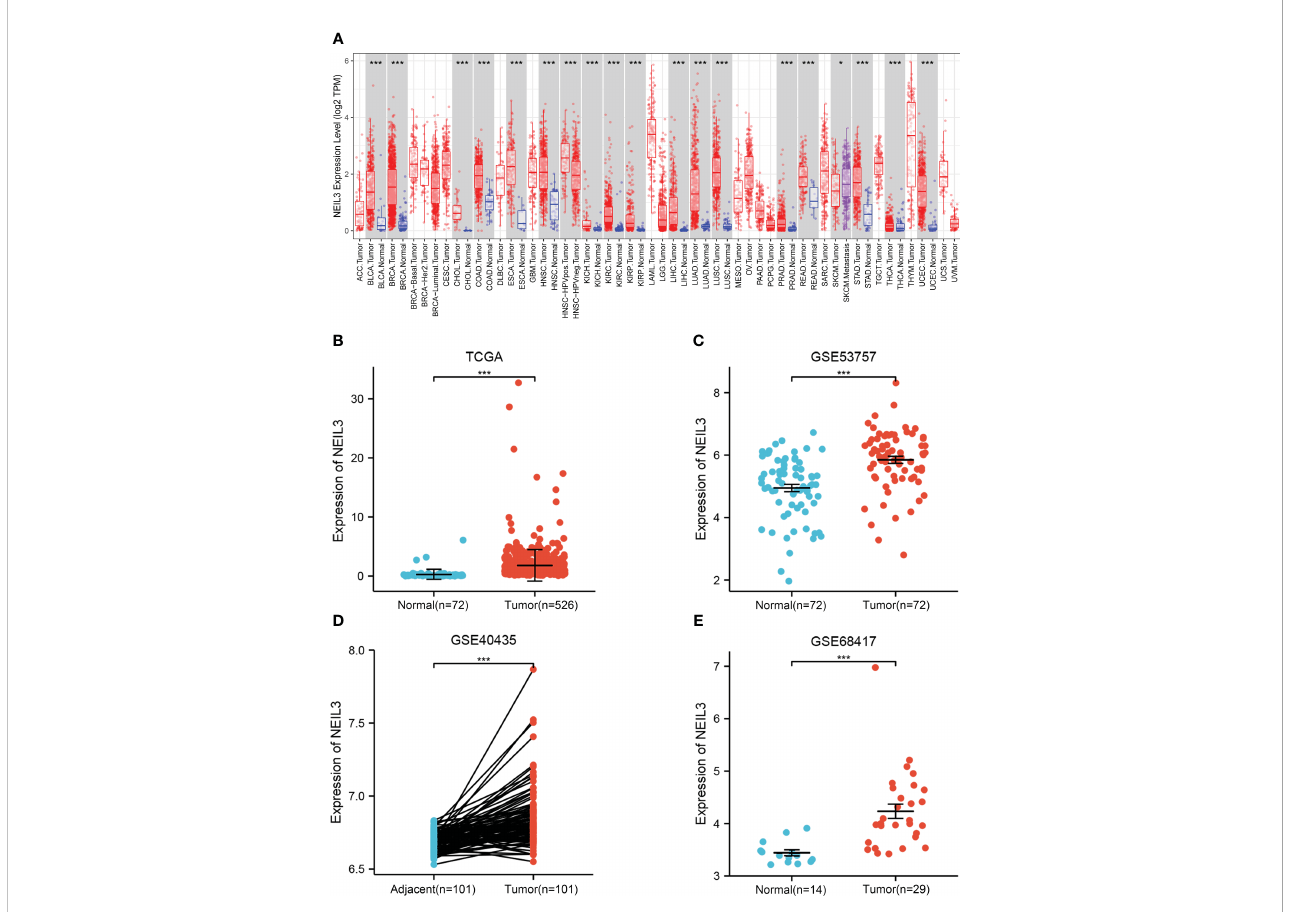
FIGURE 1 The expression level of NEIL3 is upregulated in KIRC. (A) Differential expression of NEIL3 between different tumors and adjacent normal tissues. NEIL3 is overexpressed in kidney renal clear cell carcinomas (KIRC), urothelial bladder carcinoma (BLCA), breast cancer (BRCA), colon adenocarcinoma (COAD), esophageal carcinoma (ESCA), liver hepatocellular carcinoma (LIHC), lung adenocarcinoma (LUAD). (B) NEIL3 expression level between KIRC tissues and normal tissue in TCGA. (C – E) Comparison of NEIL3 expression level between tumor tissues and normal or adjacent tissues in the GSE53757 (C) , GSE40435 (D) , and GSE68417 (E) datasets. *, P < 0.05; ***, P <